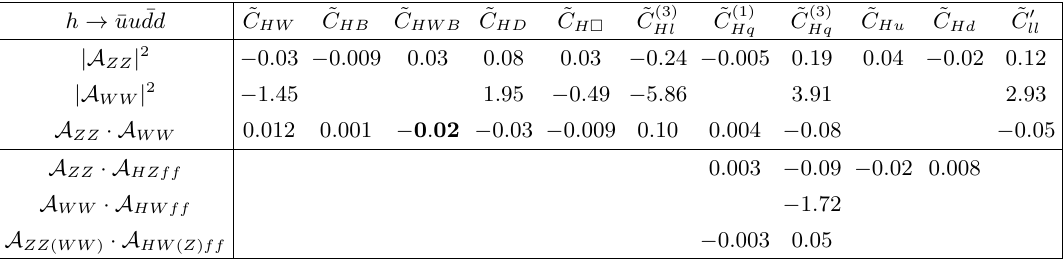
(cid:22) dd ) Table 4 . Contribution to a ((cid:22) uu from di(cid:11)erent interference terms. First block: ZZ and WW i mediated diagrams. Second block: diagrams involving contact operators. Corrections to the W; Z propagators are omitted in this table. The most signi(cid:12)cant contributions are highlighted in